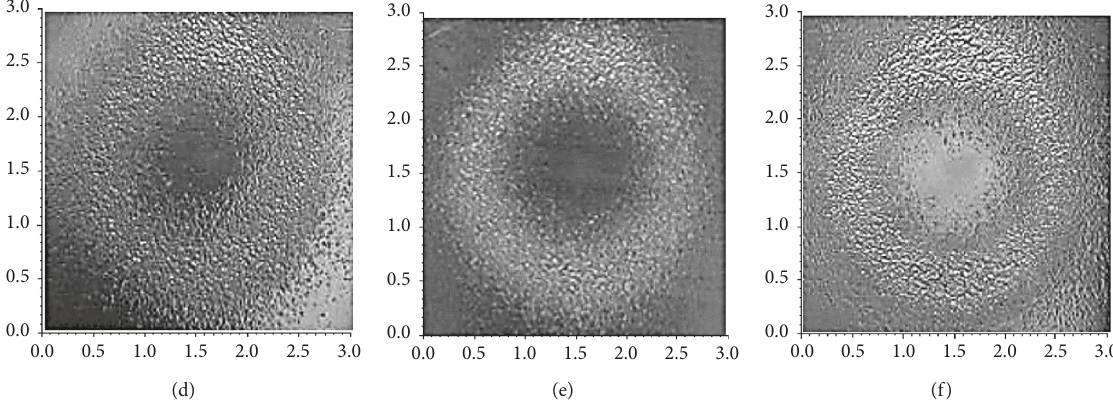
Figure 18: Erosion effects at different flow rates. (a) Q (f) Q 9.0 m 3 /h. (cid:31)